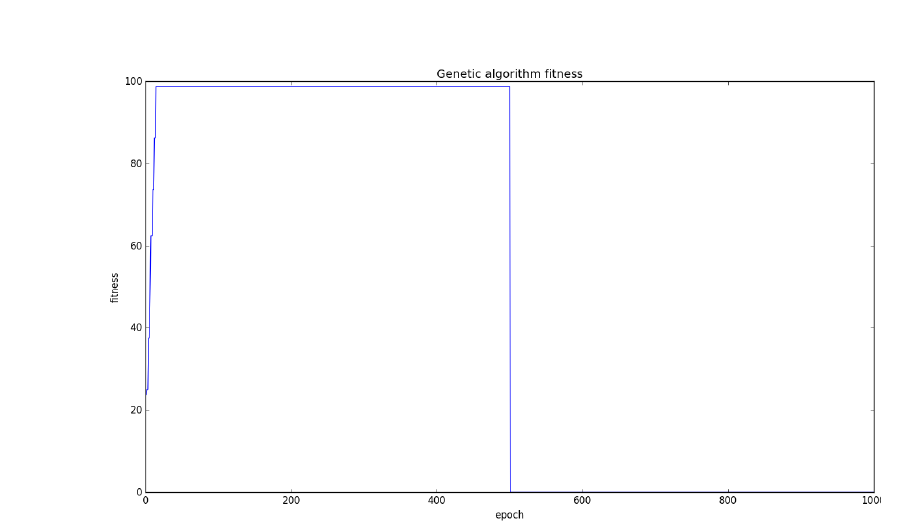
Fig. 1. Evolutionary algorithm fitness function value after switching task and changing mutation rate In the last attempt special mutation kind was proposed. After a thoughtful process it became clear that this mutation must change a lot of genes in the less fitted ones and at the same time limit the changes made to the best ones. With something like this it These trials had shown that it could work but only when performed well. The most promising one consisted of few main things combined into adaptive mutation method (listing